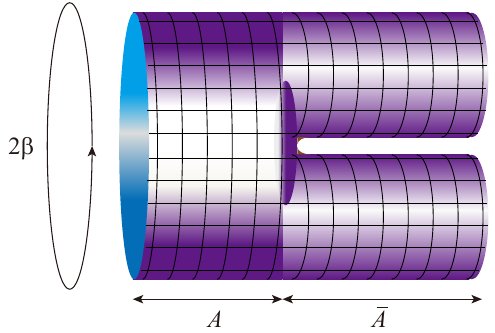
Fig. 5 The geometrical presentation of the partition function Z ð 2 Þ A . Area A of the two replicas is glued together, while area A of the two replicas are independent to each